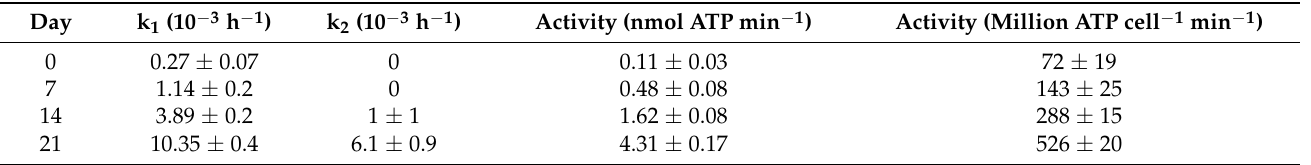
Table 1. Kinetic constants of extracellular ATP hydrolysis by MOVAS cells in the absence of levamisole on days 0, 7, 14, and 21 corresponding to the best fits (Figure S1).